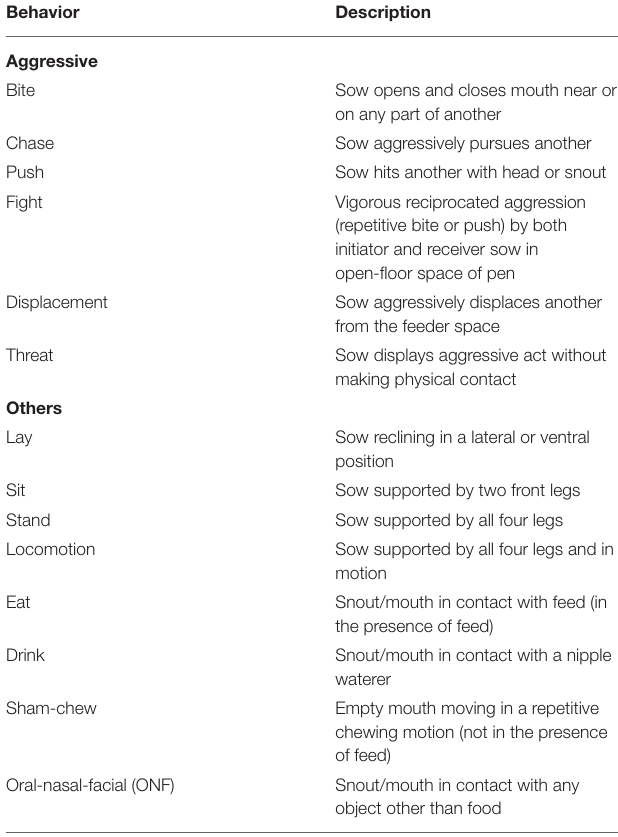
TABLE 2 | Definition of behaviors